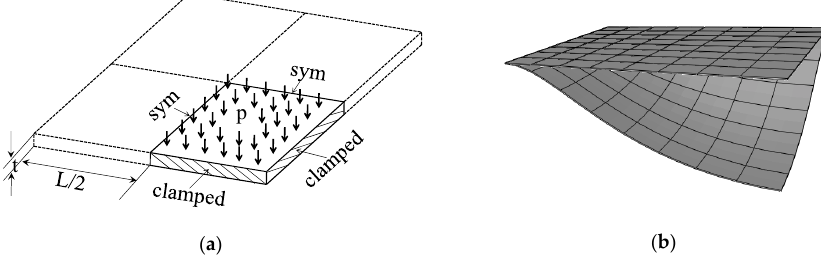
Figure 9. Clamped square plate: ( a ) geometry and ( b ) undeformed and deformed configurations. Materials 2018, 11, x FOR PEER REVIEW